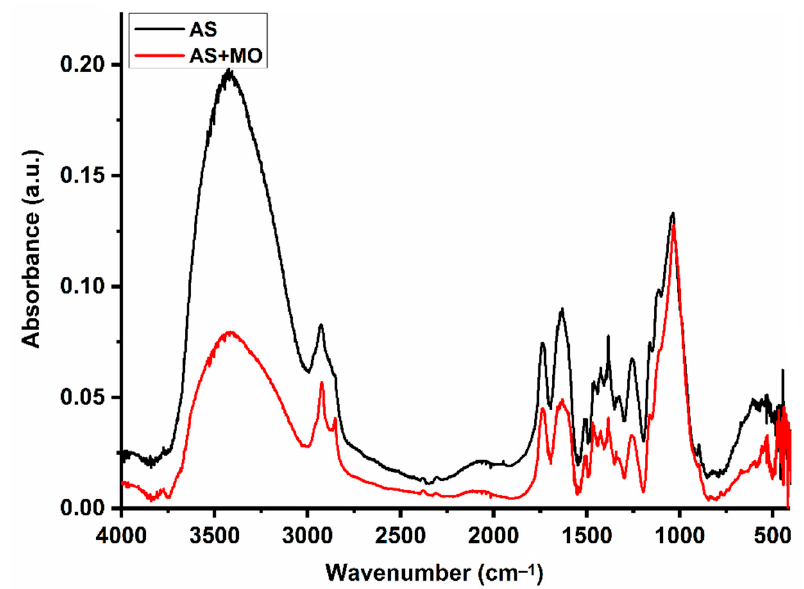
Figure 9. FTIR analysis of AS before and after adsorption